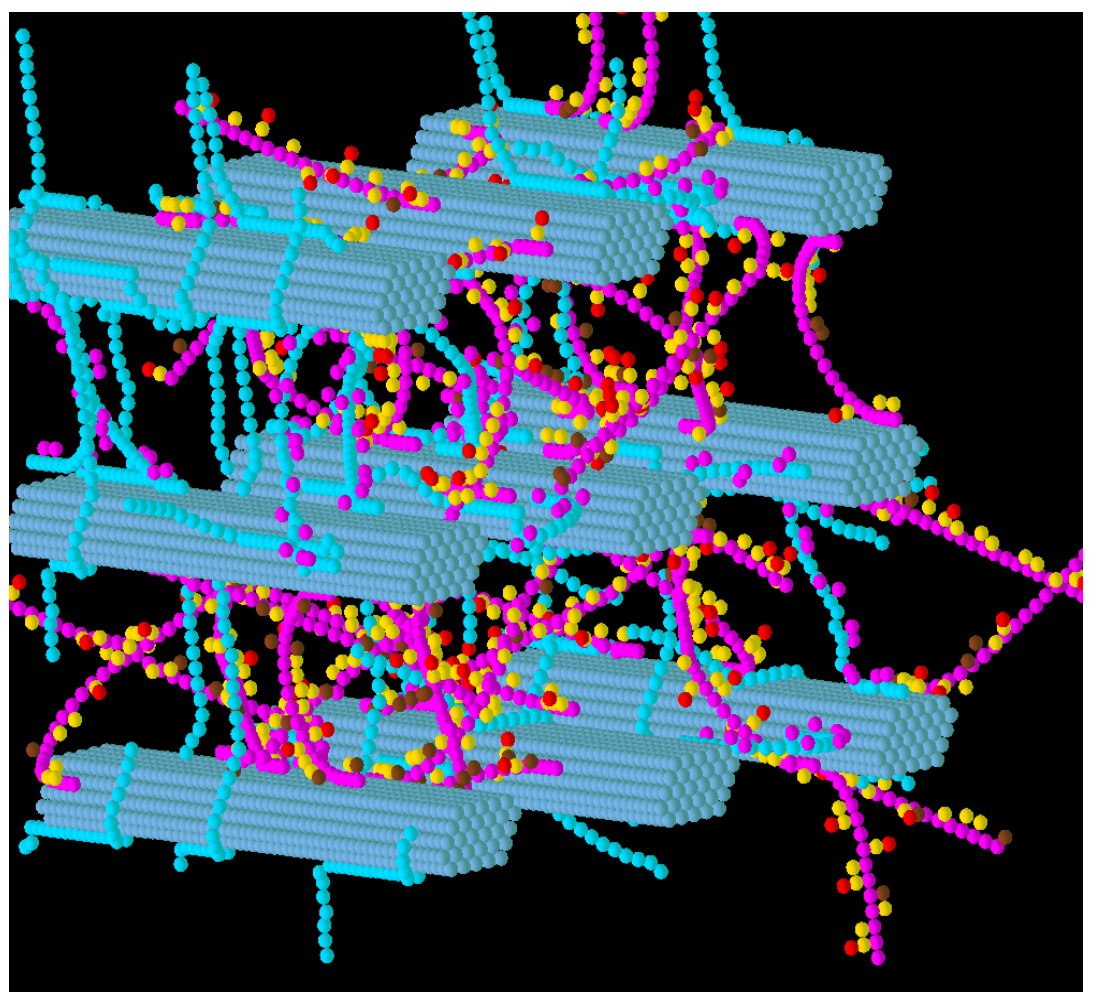
Figure 3. The second stage involved attachment of tethered and semi-tethered xyloglucans and glucuronoarabinoxylans (GAXs) to form the first hemicellulose network (shown partially complete). Glucose, xylose, arabinose, glucuronic acid and ferulic acid are represented by blue, magenta, yellow, brown and red spheres